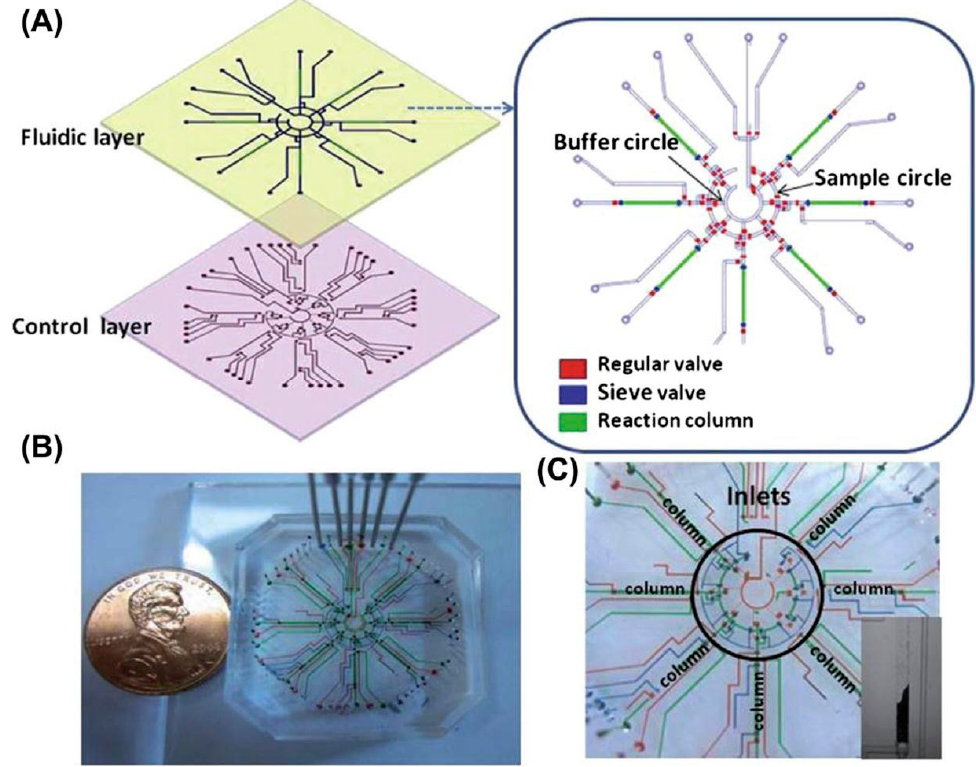
Figure 4. ( A ) Schematic representation of fluidic layers of the immunoreaction chip used in the detection of algal toxins. Valves and columns are clarified by different colors: red (grey in print versions) for regular valves (for isolation), blue (dark grey in print versions) for sieve valves (for trapping protein A beads loaded in the column module) and green (light grey in print versions) indicates the immune columns by loading of microspheres. ( B ) Optical micrograph of the microfluidic chip. The various channels have been loaded with food dyes to help visualize the different components of the microfluidic chip: control line colors are as in ( A ), plus green (light grey in print versions) for fluidic channels. A penny coin (diameter 18.9 mm) is shown for size comparison. ( C ) Optical micrograph of the central area of the chip containing seven immunoreaction columns. Inset: a snapshot of the protein A beads loading process in action [22].